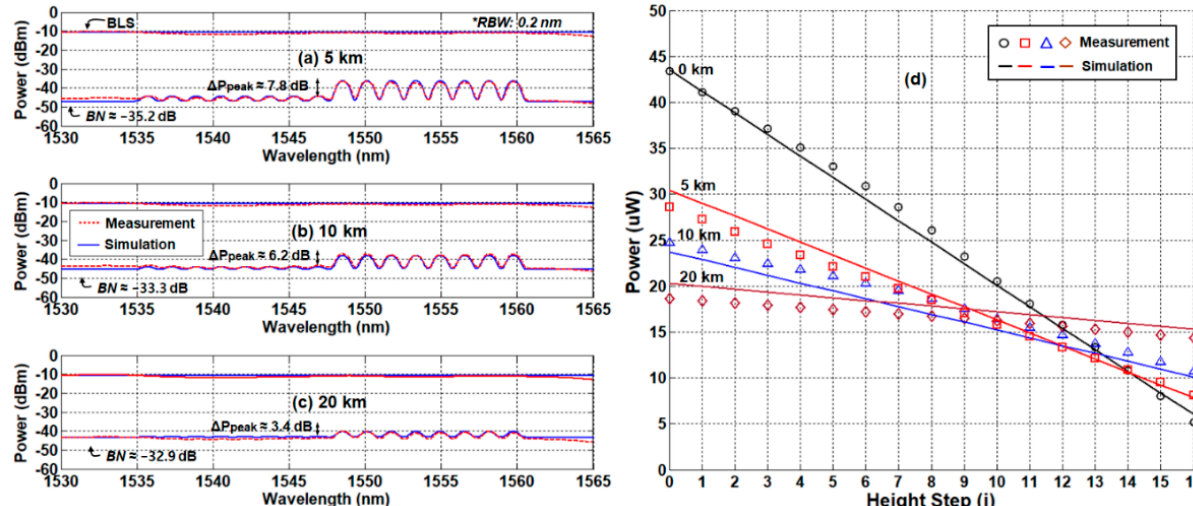
Figure 6. Simulation and measurement results at the different distances in the single-path configuration network. ( a ) The spectra of 1/2 water level at 5 km, ( b ) the spectra of 1/2 water level at 10 km, ( c ) the spectra of 1/2 water level at 20 km, and ( d ) optical-received power as a function of the water level.